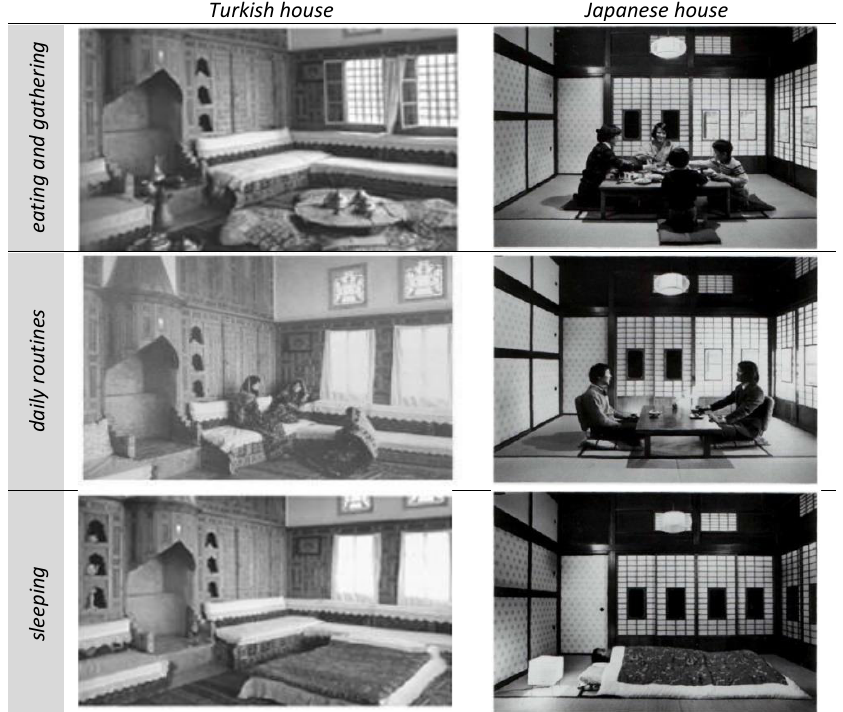
Table 1 Multi-functional characteristics of the traditional spaces , (Günay; 1999, Nergis;